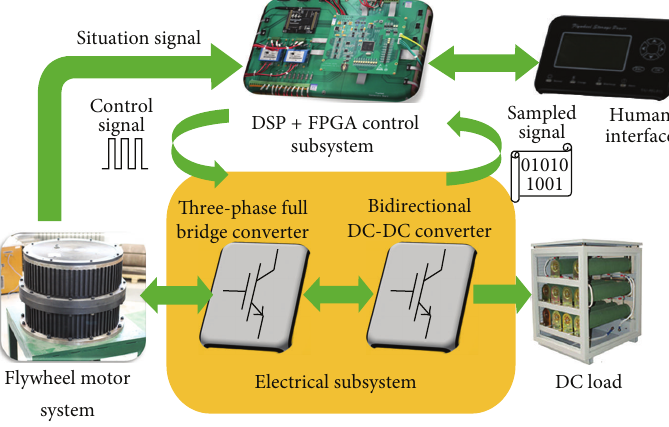
Figure 2: Structure of the FESS.